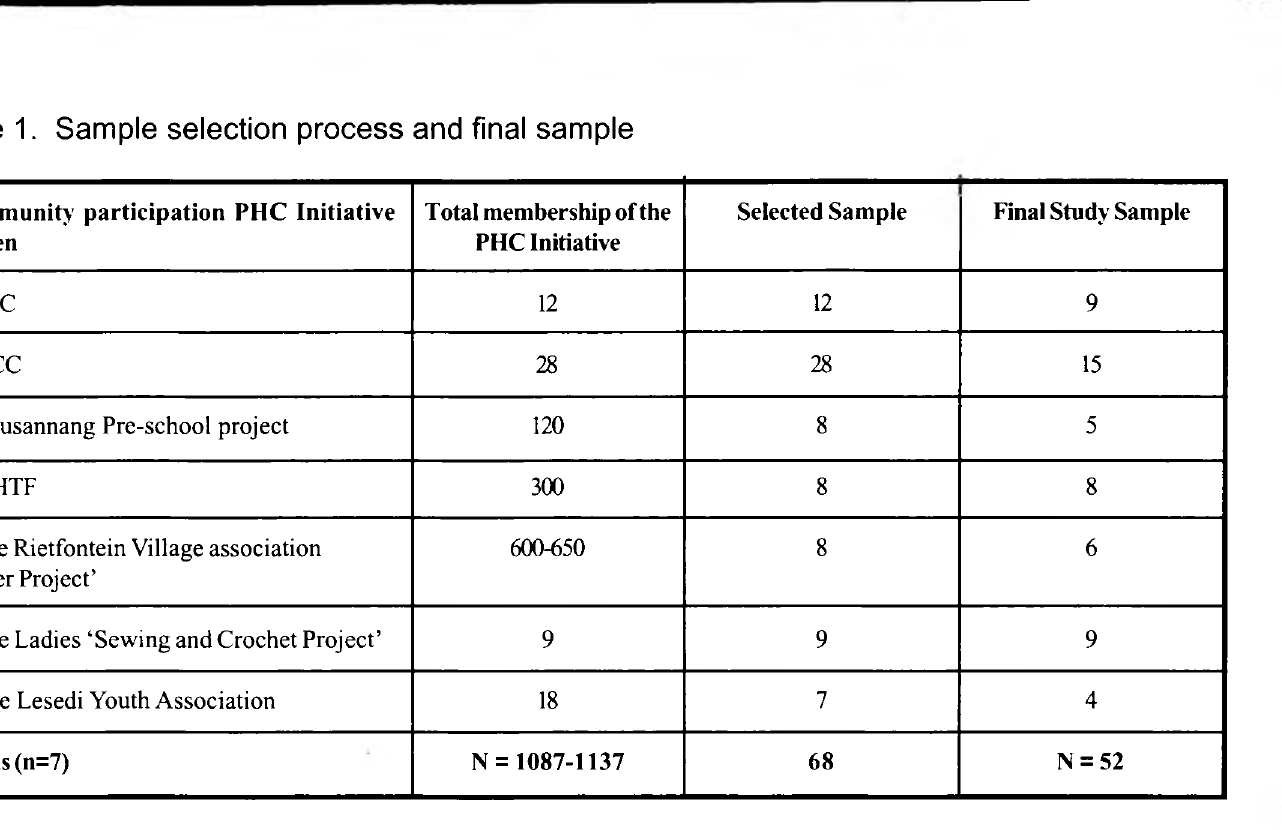
Table 1. Sample selection process and final sample